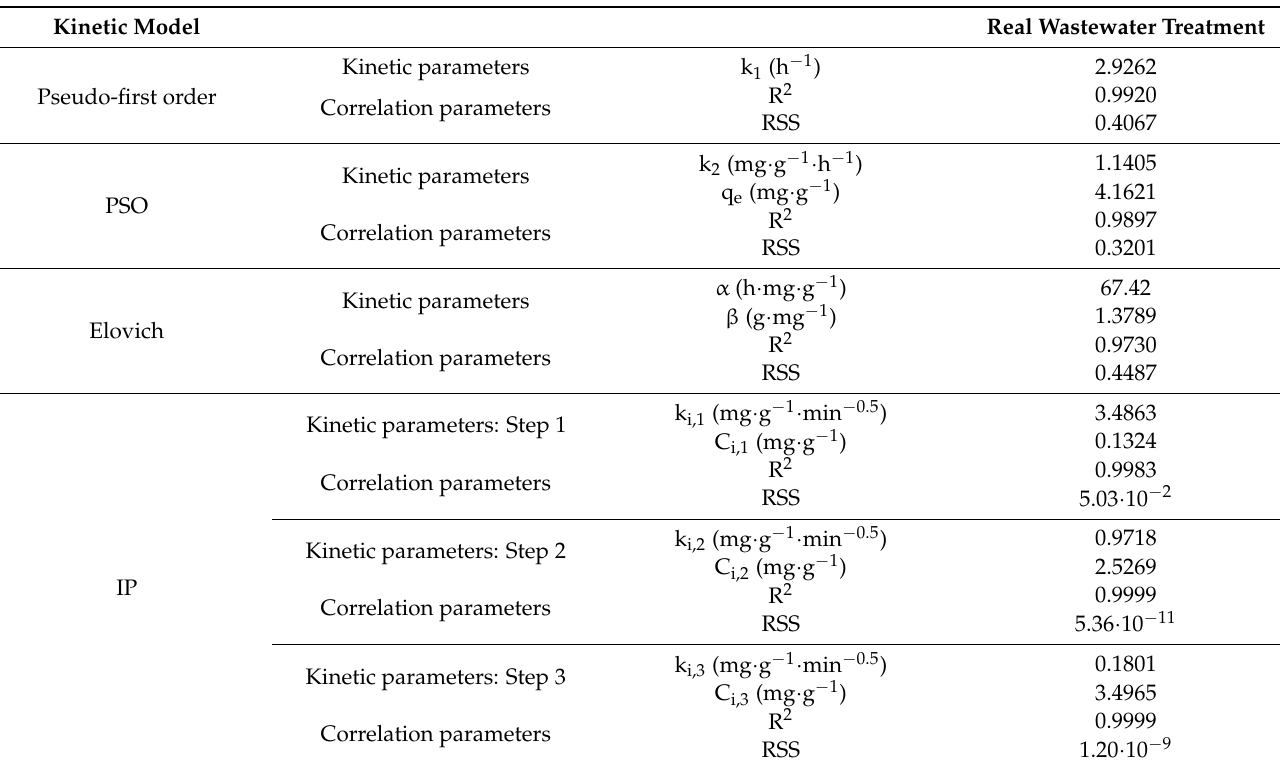
Table A6. Adjusted kinetic and correlation parameters of different kinetic models fitted to the experimental data of hexavalent chromium adsorption on real wastewater